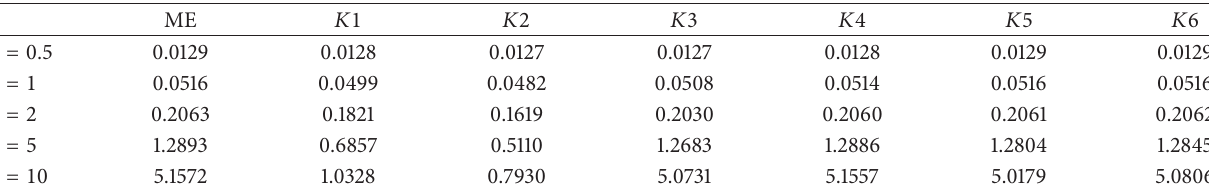
Table 5: Estimated MSE with 𝑛 = 100 , 𝑝 = 4 , and 𝛾 = 0.75 .